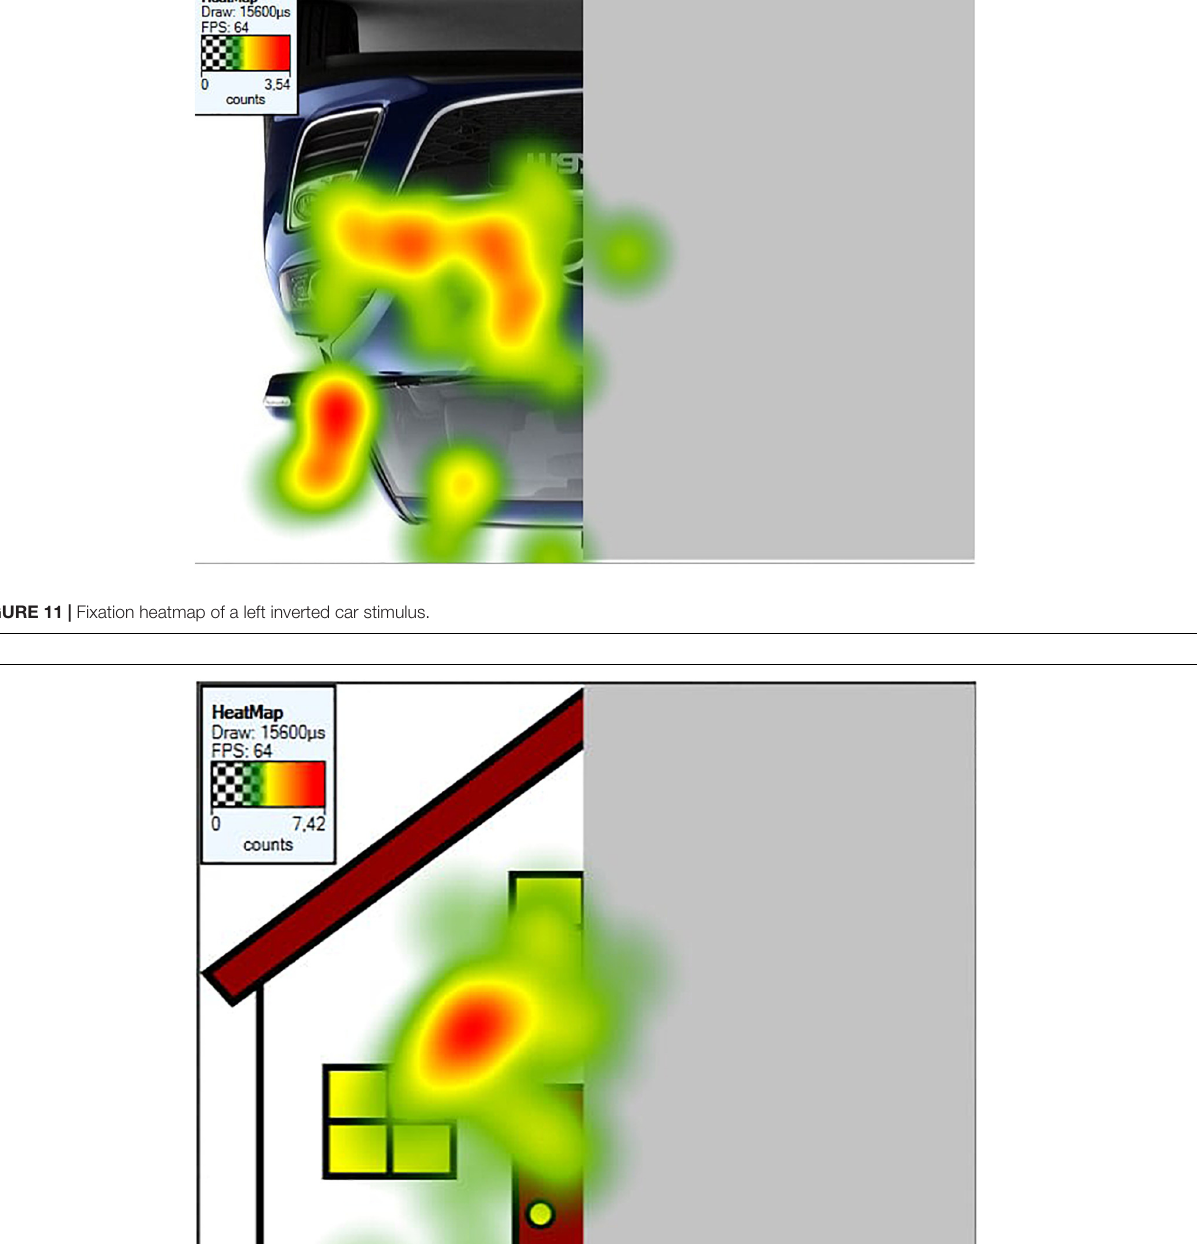
the out of AOI was fixated more than the eye ( p = 0.004; p < 0.001 for faces and objects, respectively), the eye region was fixated more in the case of faces (compared to objects), and the out of AOI was fixated more for objects (compared to faces) ( p =